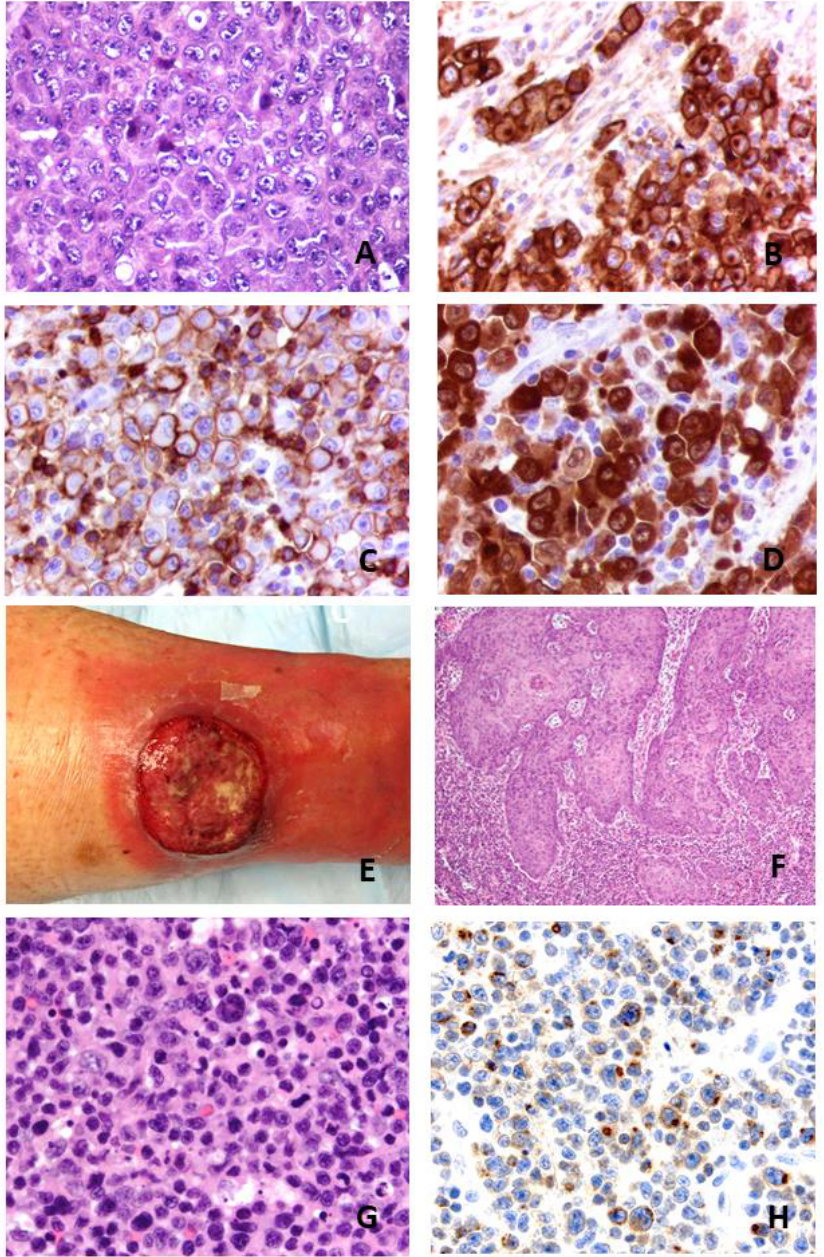
Figure 1. Morphological features of systemic ALK+ anaplastic large cell lymphoma. ( A ): HE: hematein and eosin staining × 400. Common morphological variant with hallmark cells. ( B – D ): CD30, EMA and ALK immunostainings ( × 400). Courtesy of Dr Marie Parrens, CHU de Bordeaux, Pessac, France. Clinical and pathological features of a cutaneous anaplastic large cell lymphoma. ( E ): Tumor of lower leg. ( F ): Pseudoepitheliomatous hyperplasia on HE stain (×200). ( G ): Cytomorphology on HE stain (×400). ( H ): IL-17A immunostain of tumor cells (×400).